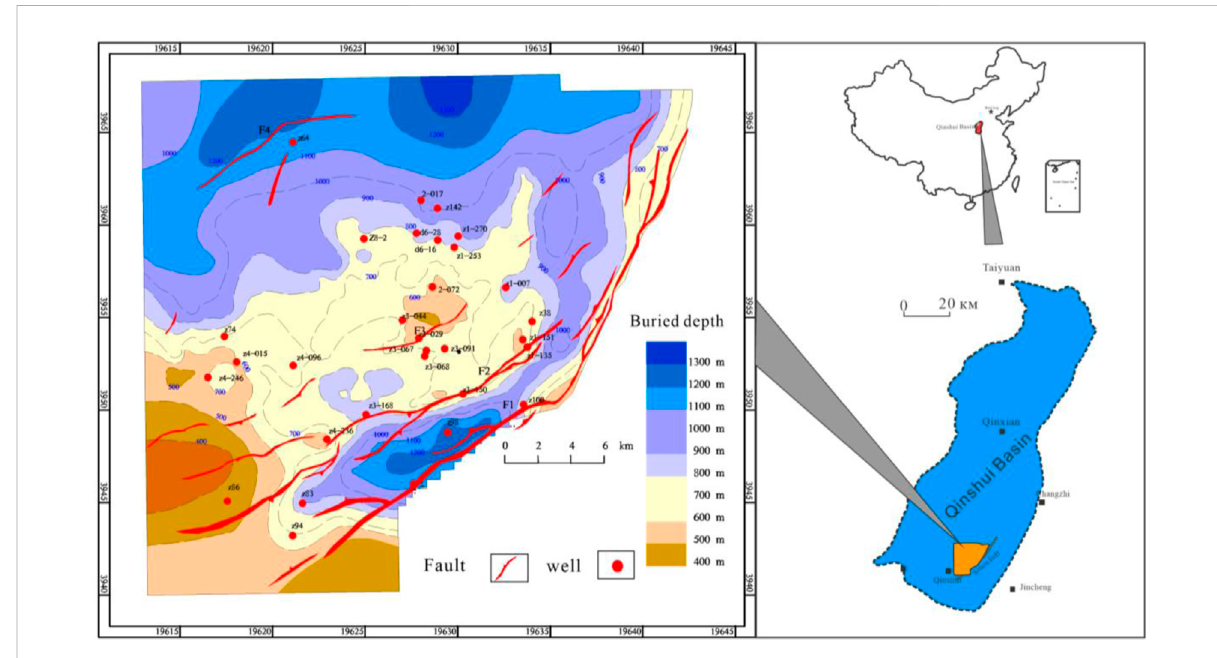
FIGURE 1 Location map of Zhengzhuang Block (modi fi ed according to Zhu and Li according to the literatures Li et al., 2016 and Zhu et al., 2018).